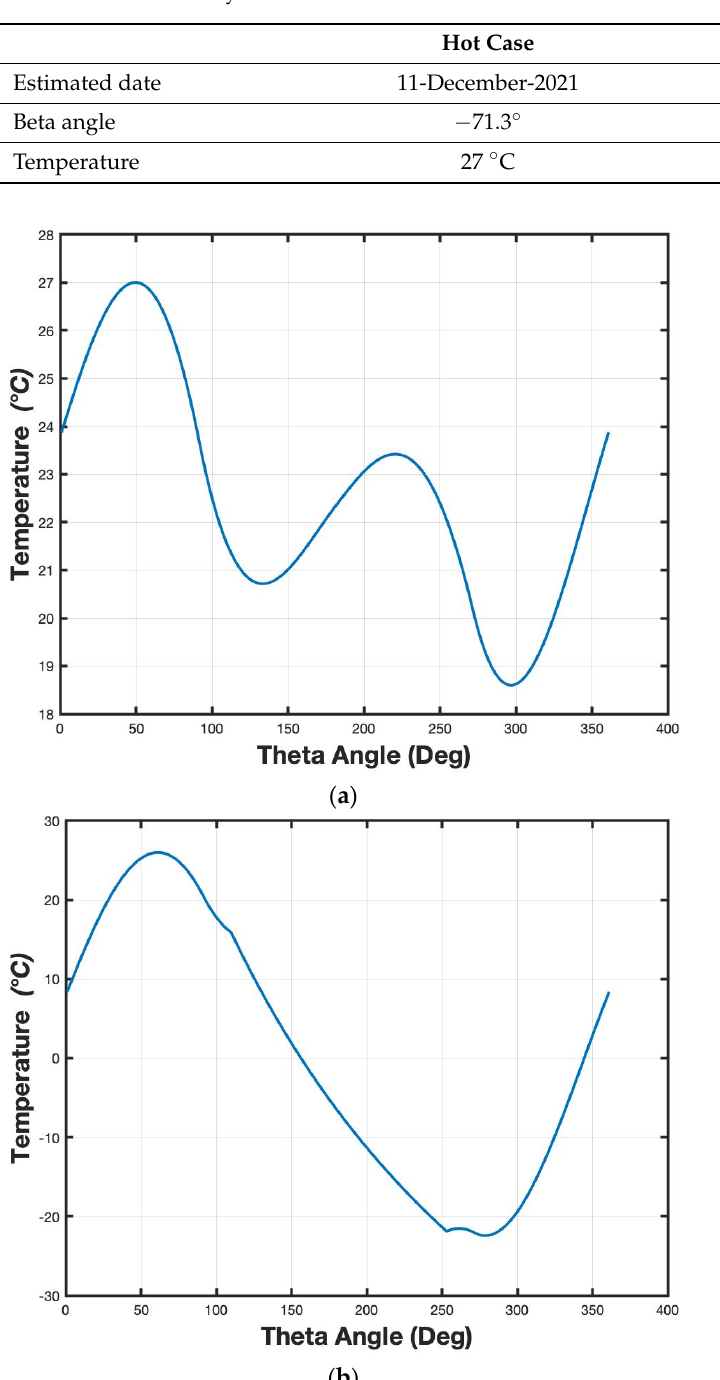
Table 15. Thermal analysis worst case results.